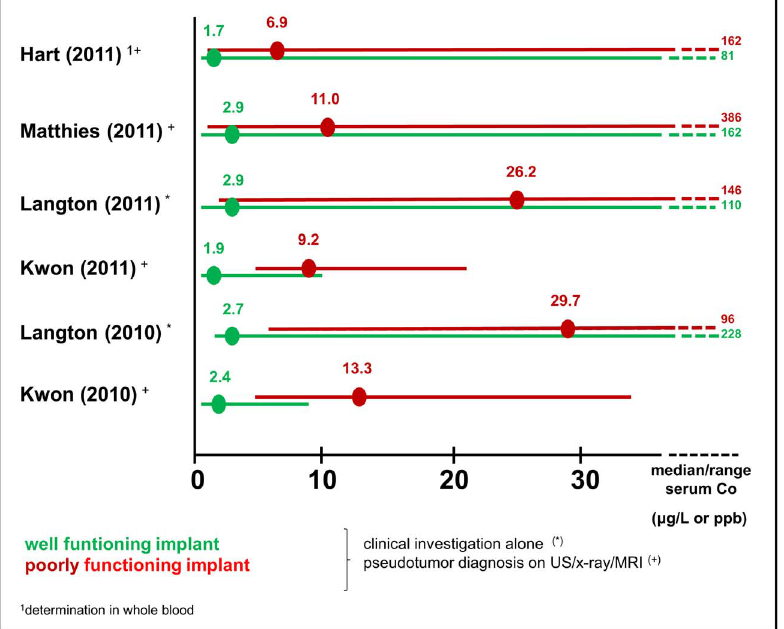
Figure 3. Summarizes six studies which reported Co-concentrations in well and poorly functioning implants [ 55,18,19,20,53 ] . Cases with local metal-related adverse reactions (poorly functioning implants) had consistently higher metal ion concentrations than patients with well- functioning THA.